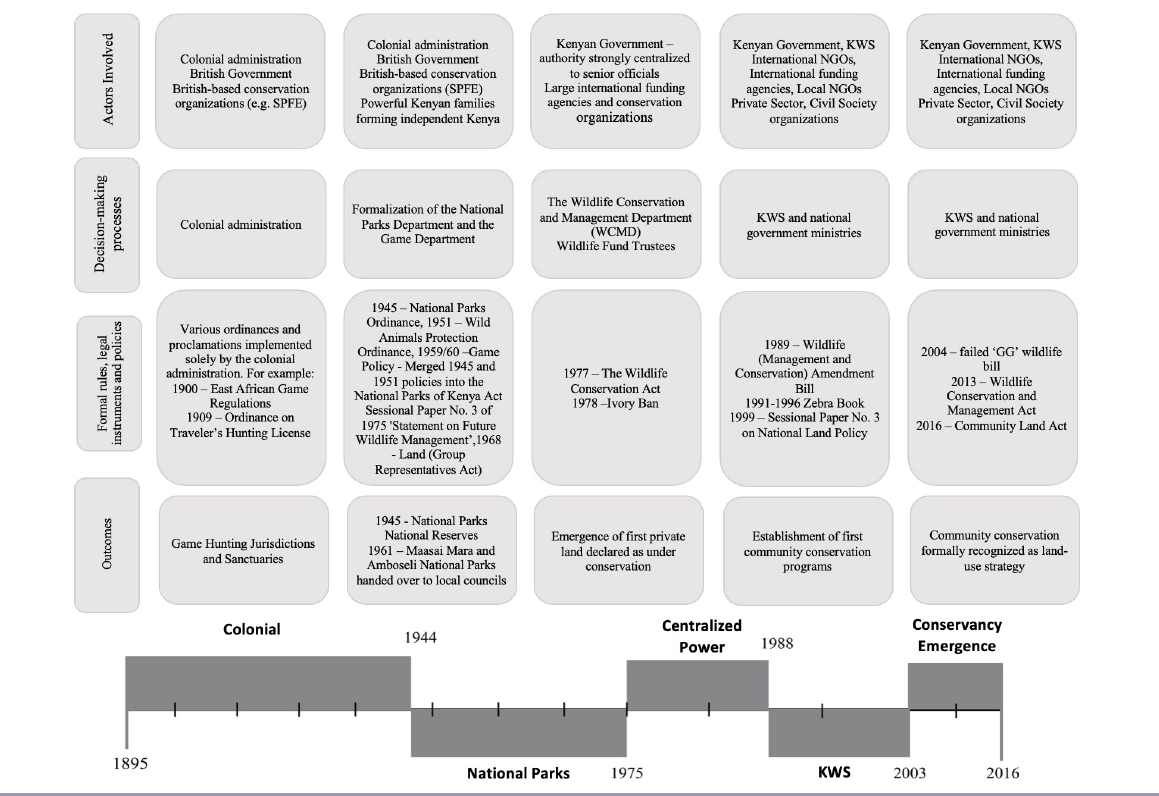
Fig. 3 . Historical time line, 1895–2016.